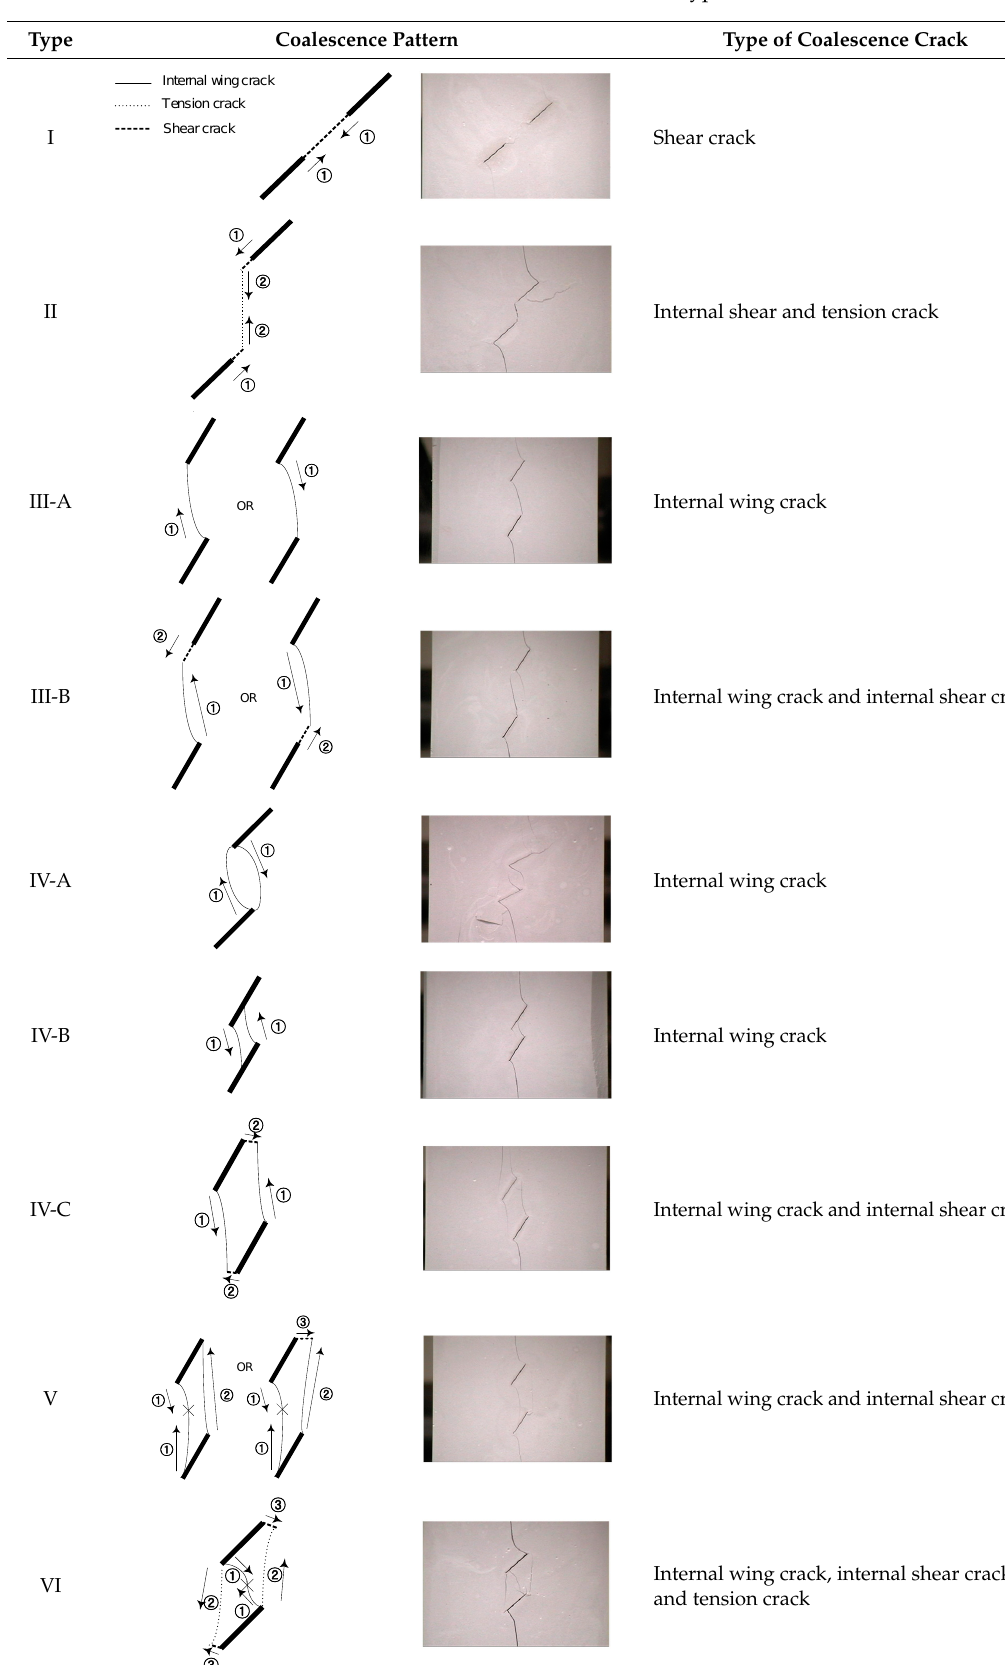
Figure 12. Relationship between the loading rate and fracture strength for determining the subcritical crack growth parameter under monotonic loading. τ * is given by: